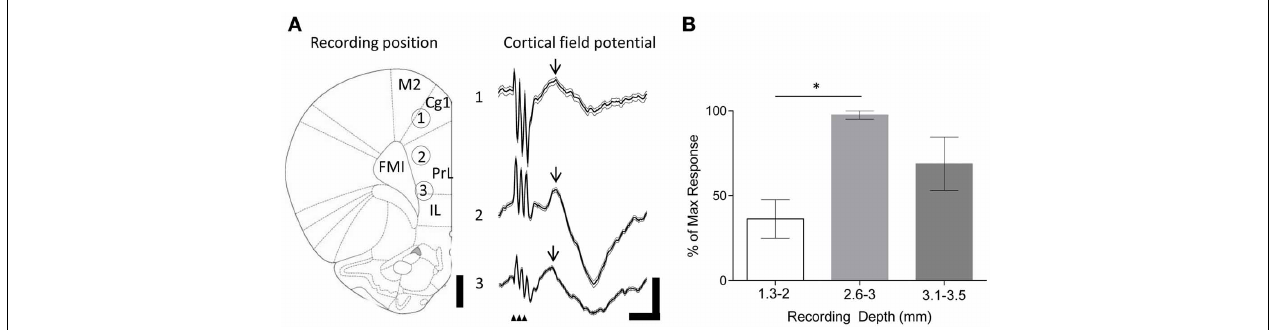
FIGURE 2 | Evoked field potentials in the frontal cortex following FN stimulation in behaving rats. (A) Example experiment illustrating averaged (thick black line) field potentials (72 trials) recorded from tetrodes at different depths in the frontal cortex following stimulation of the FN (recording positions indicated by numbers on rat brain schematic adapted from Paxinos and Watson (2006); small arrowheads indicate timing of FN stimulation artefacts; M2, supplementary motor cortex; Cg1, cingulate cortex; IL,